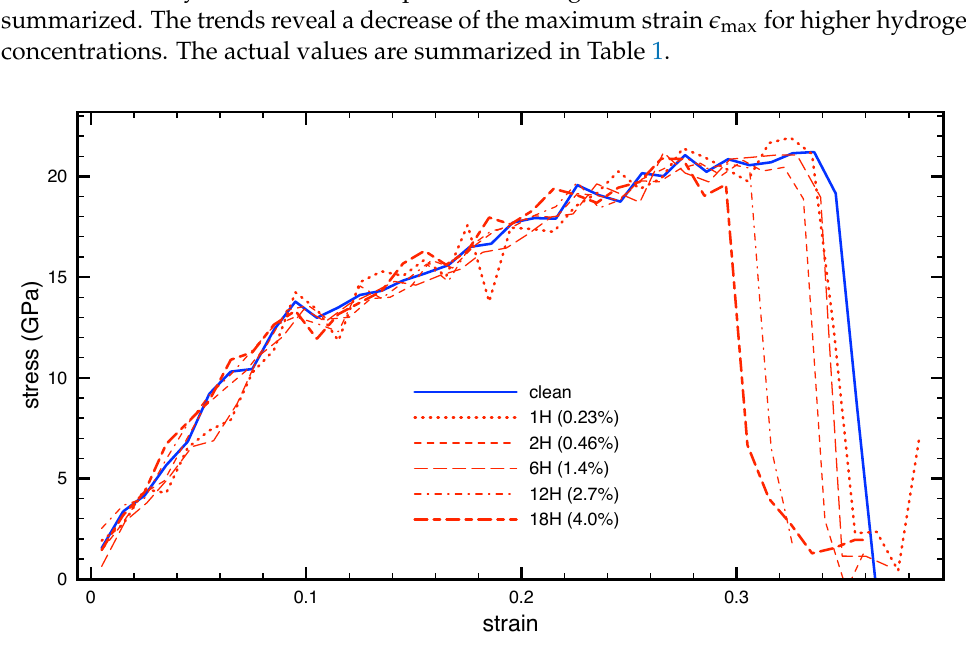
Figure 6. The computed stress-strain dependencies for different H